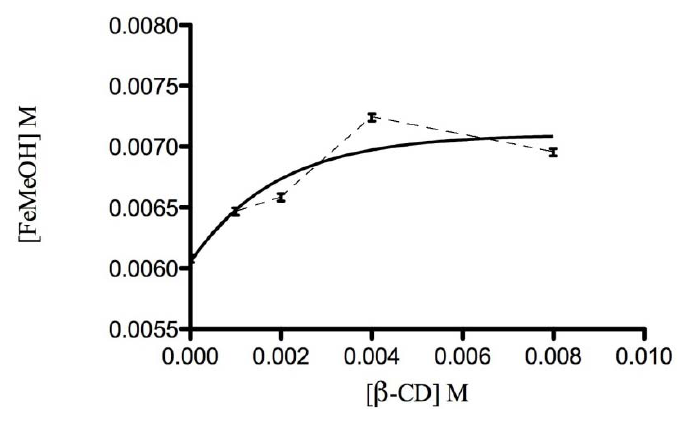
Figure 6. PSD for the complex FeMeOH: β